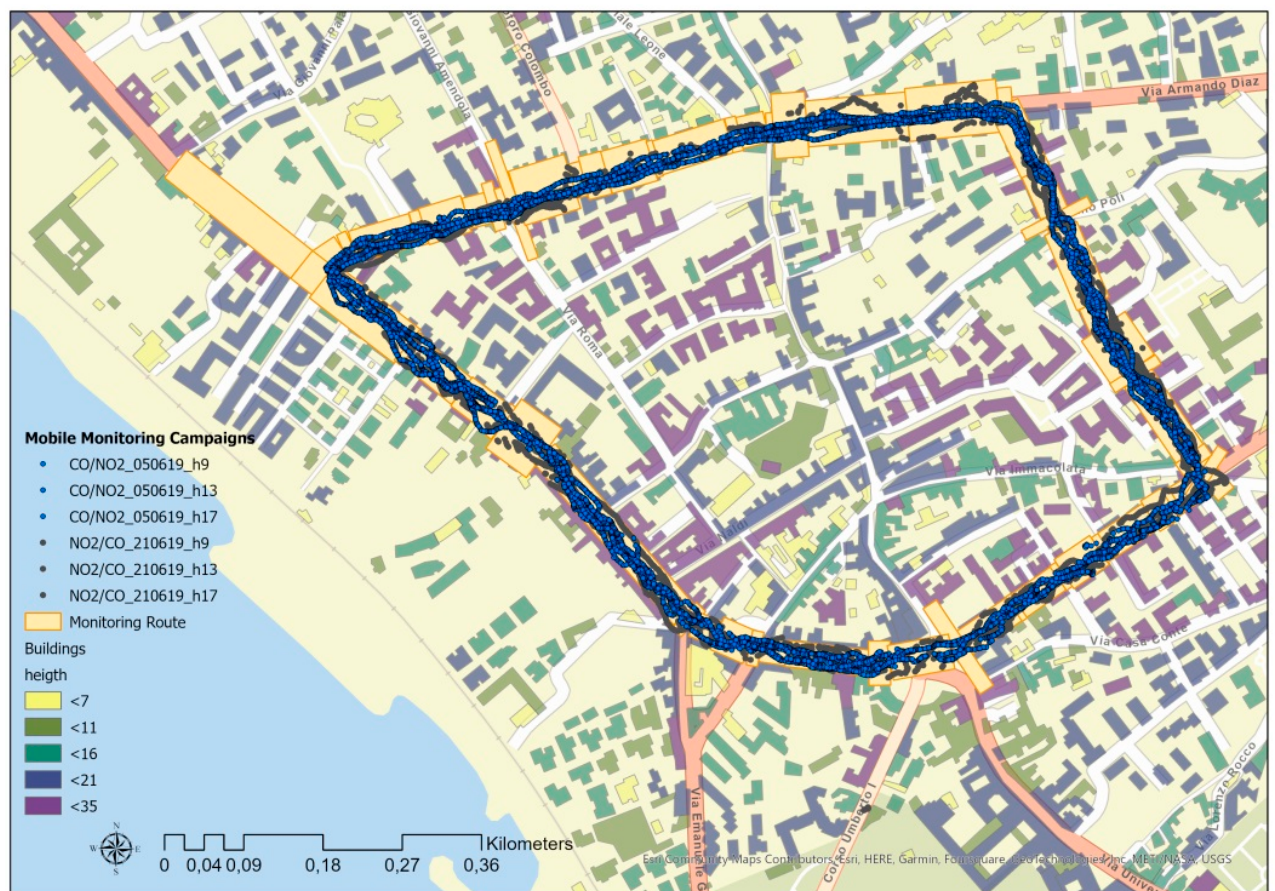
Figure 3. Maps of the mobile monitoring campaigns along the selected monitoring route.